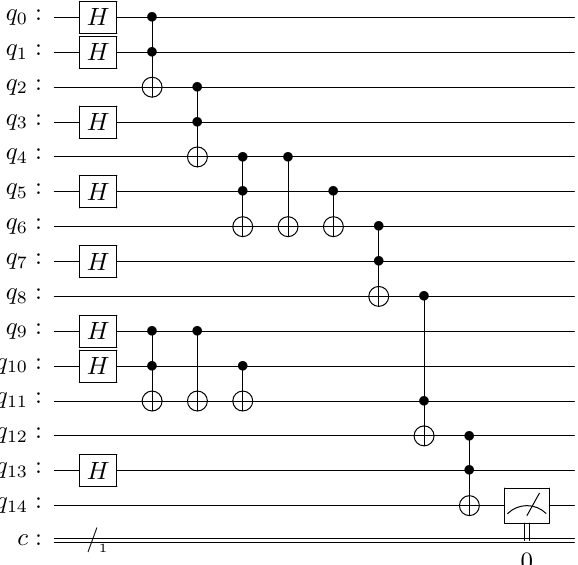
Figure 9. The quantum version of the classical inferential circuit described above.